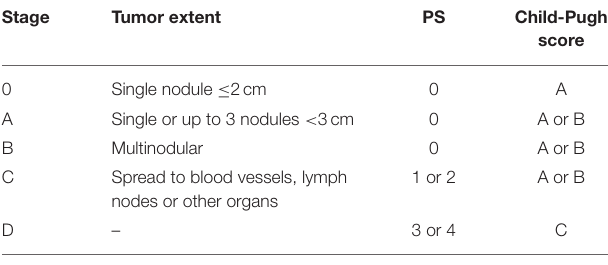
TABLE 1 | Barcelona clinic liver cancer staging